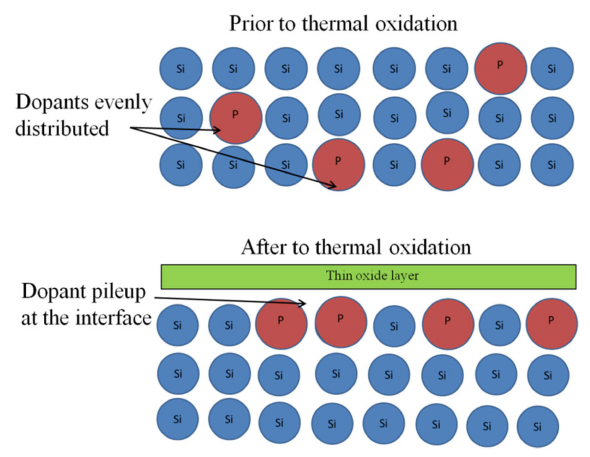
Figure 3. Illustration of phosophorous dopant atom redistribution and pile-up at the Si/SiO 2 interface due to thermal